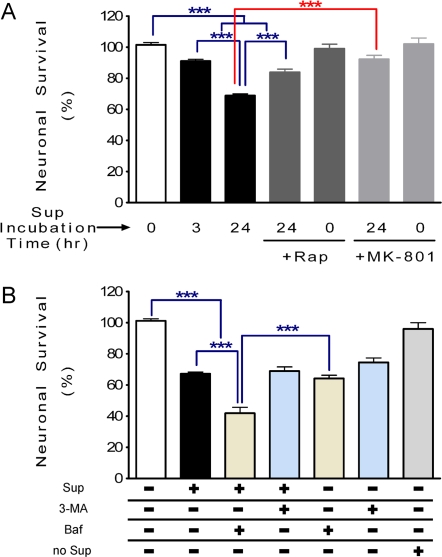
Neuronal survival after exposure to SIV-infected microglia supernatant in the presence of different autophagy related drugs.(A). Neuronal survival tested by MTT. There are significant decreases of neuronal survival after exposure to SIV-infected microglia supernatant for 3 or 24 hr, which is significantly abrogated in the presence of rapamycin. Rapamycin alone has no effect. MK-801 (100 µM) also prevented the neurotoxicity induced by SIV-infected microglia supernatant. *** P<0.001, for n = 6 experiments. (B) Neuronal survival was examined with MTT in cultures exposed to SIV-infected microglia supernatant for 24 hr and in the presence or absence of different drugs such as 3-MA (1 mM) or Baf (100 nM). There is no significant difference between cells exposed to SIV-infected microglia supernatant and a pretreatment with 3-MA followed by exposure to SIV-infected microglia supernatant. However, there is a significant decrease of neuronal survival exposed to SIV-infected microglia supernatant when cells are pretreated with Baf. The SIV-infected microglia supernatant from no infected monkey (no Sup) doesn't affect neuronal survival and there is no significant difference with control samples. All values are mean±SEM.